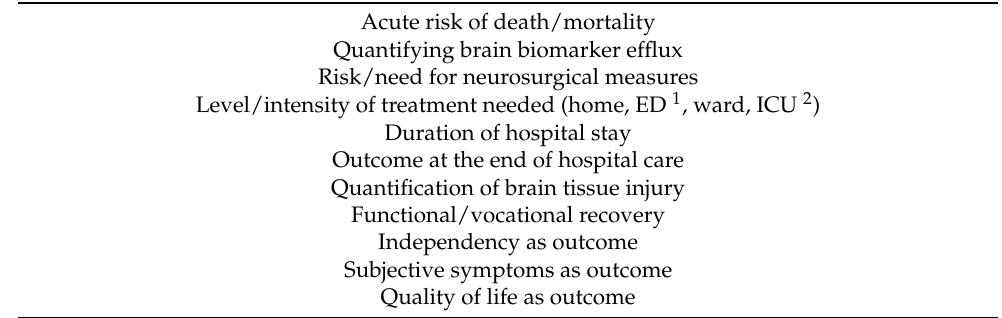
Table 1. Different viewpoints on TBI